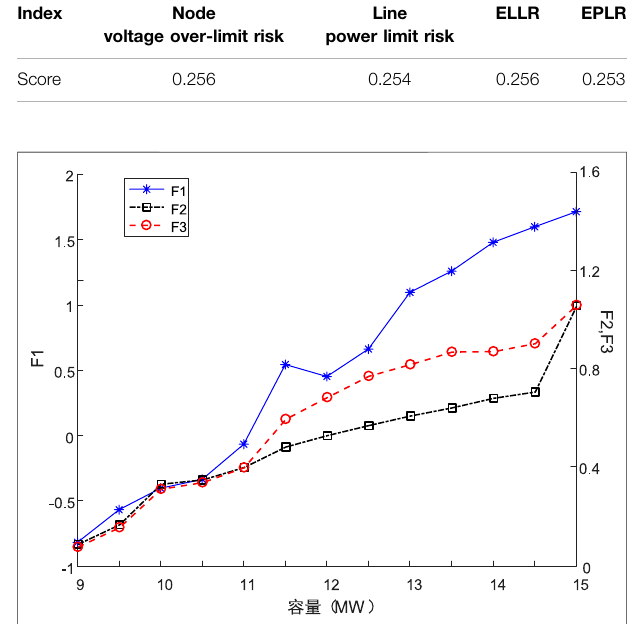
TABLE 6 | Component score coef fi cient.